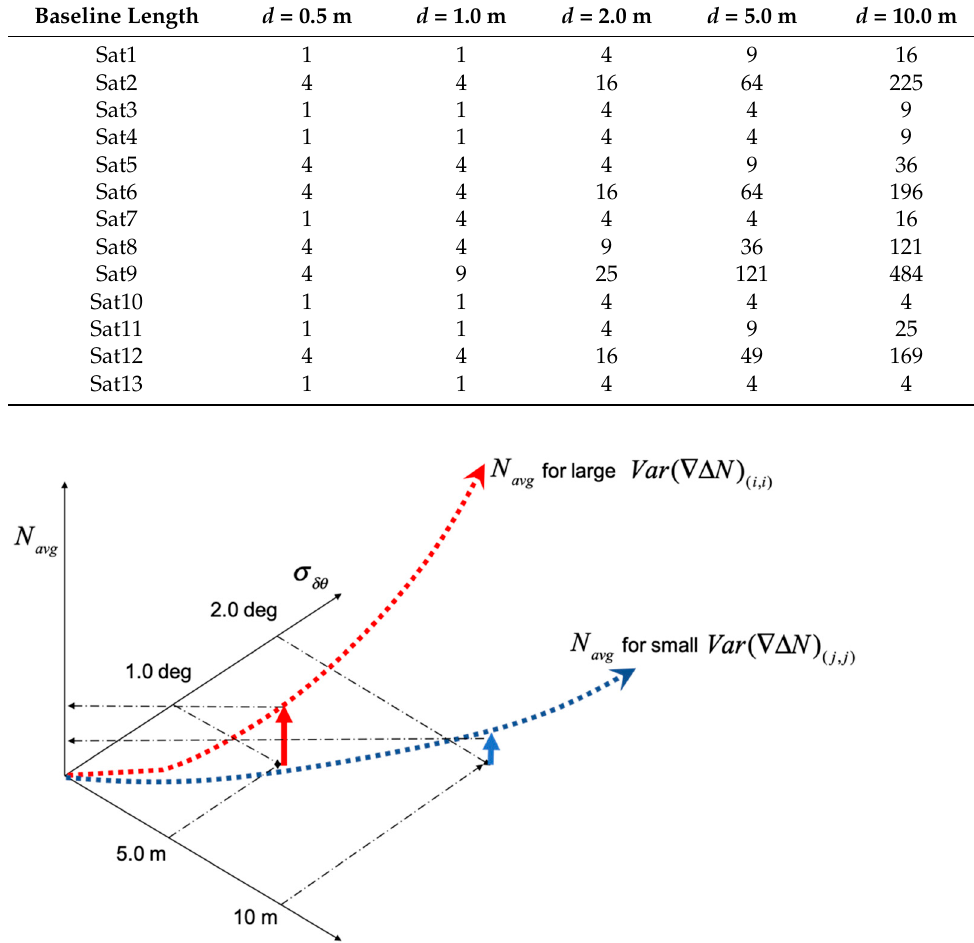
σ of 0.1 cycles with five cases of ˆ N ∇Δ = 2.0 °. δθ of 0.1 cycles with five cases of N = 2.0 ◦ . δθ